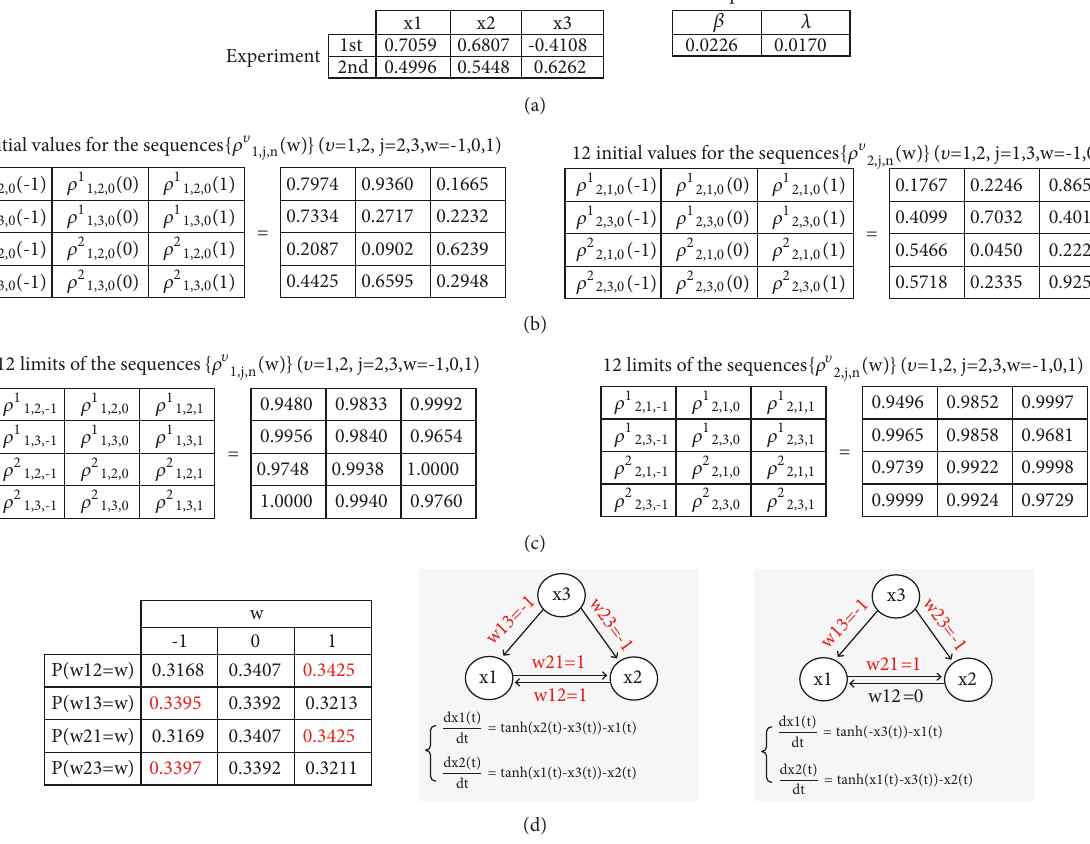
Figure 6: Approximate marginal PMFs. (a) The experimental data and cost parameters (𝛽, 𝜆) are the 61 𝑡ℎ data set and its corresponding values of (𝛽, 𝜆) in Figures 3(a) and 3(b), respectively. (b) 12 initial values in the left and right denote the values in the 61 𝑡ℎ initial data set in Figures 4(a) and 4(b), respectively. (c) 12 limit values in the top and bottom are obtained for Figures 6(a) and 6(b). (d) The approximate marginal PMFs are obtained from (89) and (93). The red numbers denote the maximum values of the marginal PMFs. The first network and its mathematical model in the right denote those in Figures 1(a) and 1(c) with link weights of maximum values. Replacing 𝑤12 = 1 in the first network with 𝑤12 = 0 gives the second network and its mathematical